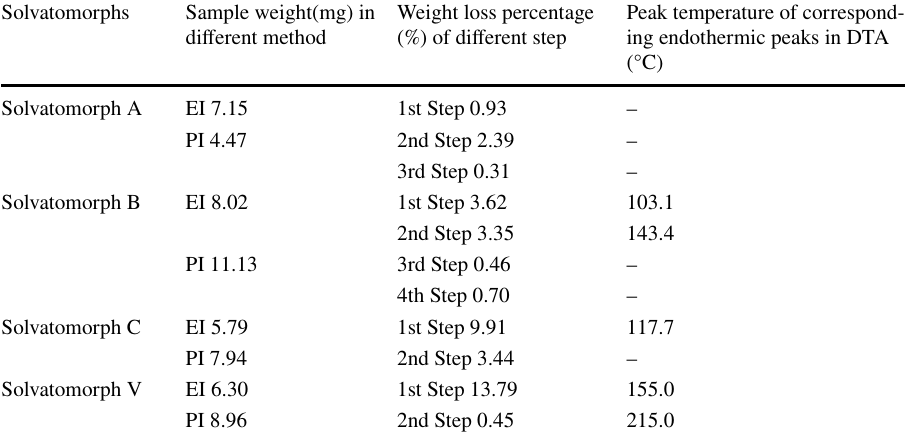
※ “–” means that corresponding endothermic peaks in DTA curves was not